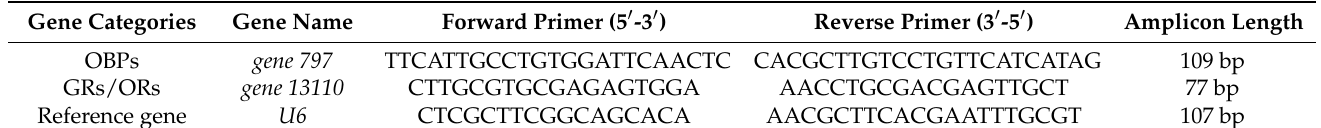
Table 3. Gene testing information: the selective genes and their primers used in qRT-PCR.